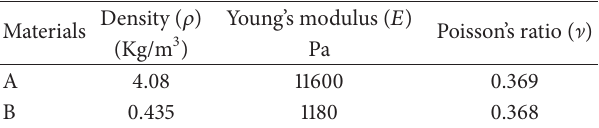
Table 1: Materials